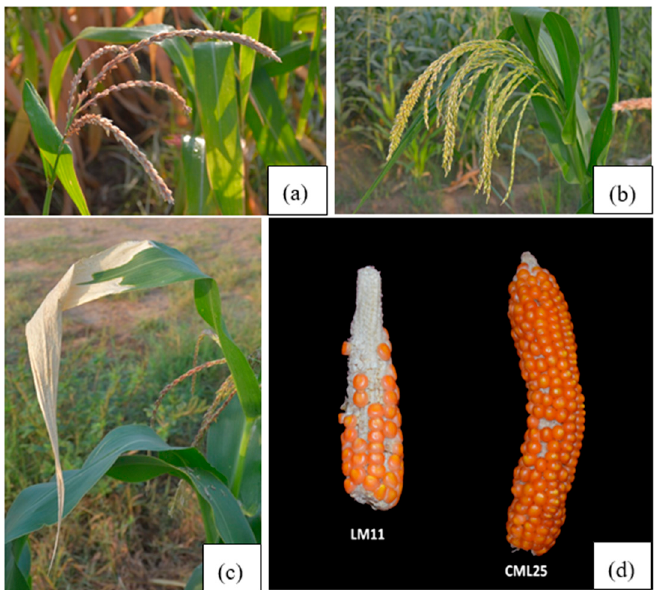
Figure 8. The impacts of heat stress on various phenological attributes between LM11 and CML25. ( a ) tassel blast in LM11, ( b ) no tassel blast or top leaf firing in CML25, ( c ) top leaf firing in LM11, ( d ) variations in kernel number and ear size.